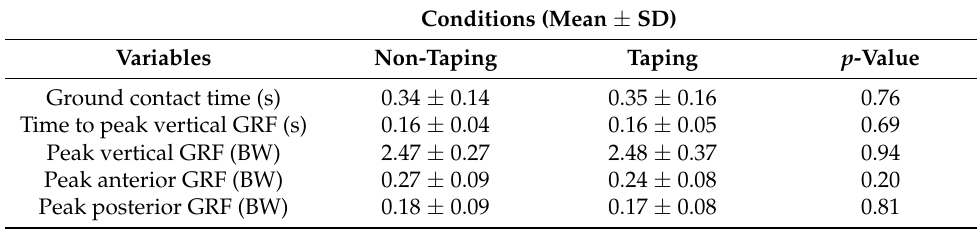
Table 1. Ground contact time, peak GRFs, and time to peak vertical GRF.